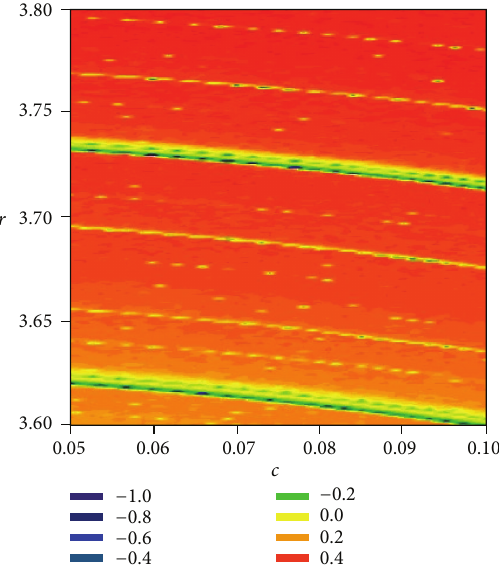
Figure 2: Lyapunov exponent of the coupled system (11), which shows presence of strait regions of stability in highly developed